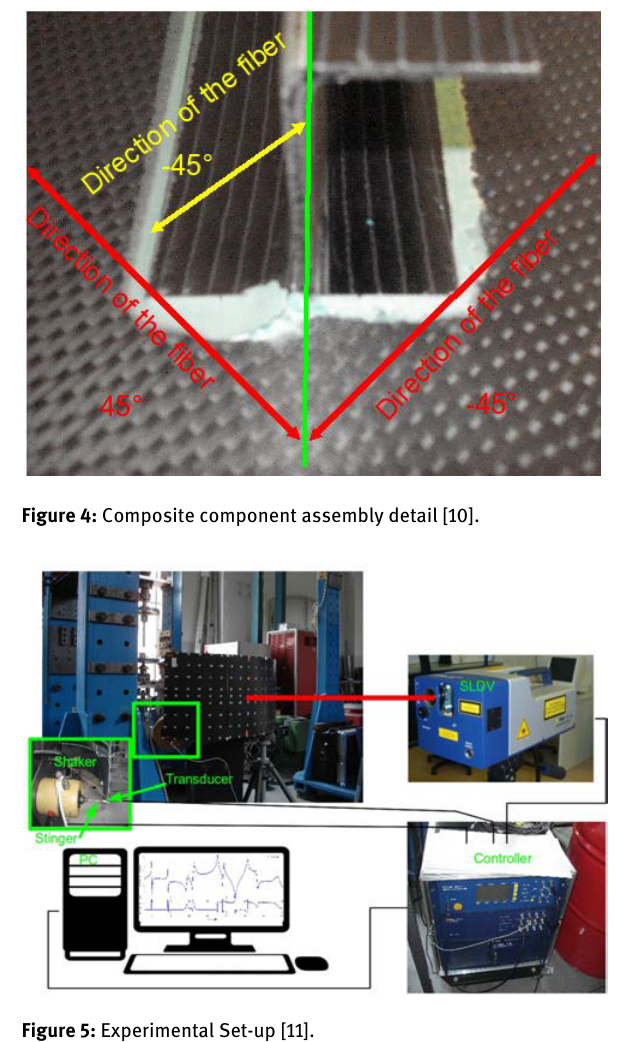
Ly 564 + Hexcel Gewebe G0926 (HTA-Faser) with dimen- sions of 0.390m × 0.810m (Figure 3 front and back part).